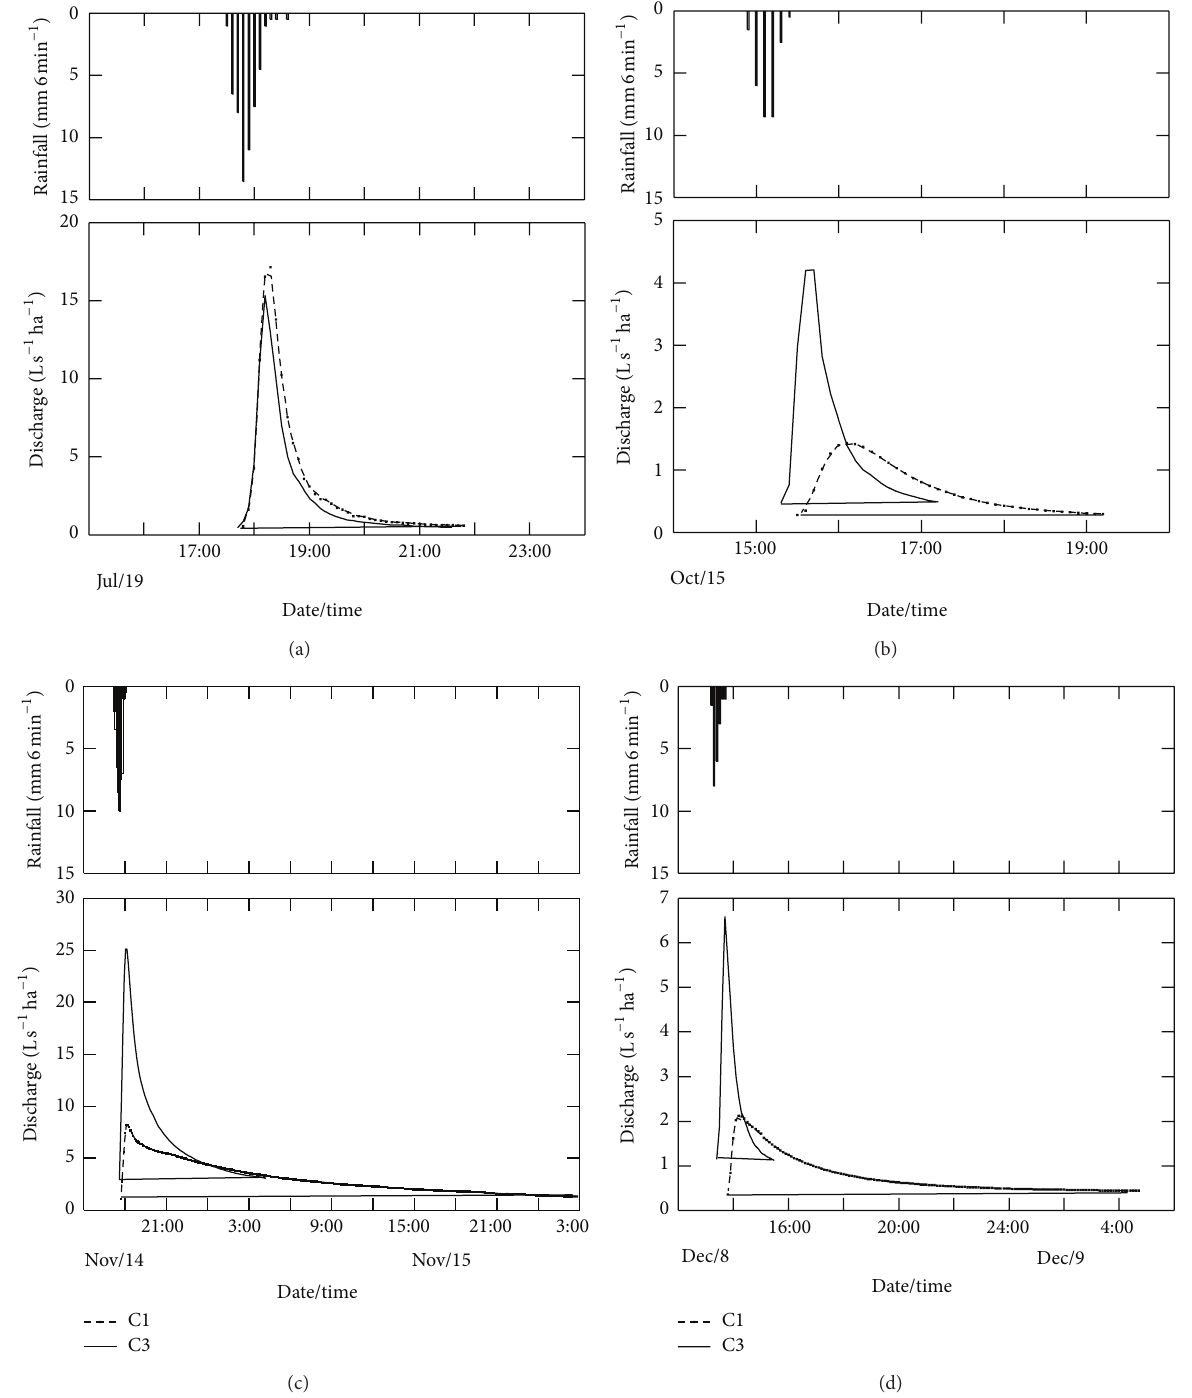
Figure 4: Stormflow hydrographs for C1 and C3 during (a) dry condition on 19 July 2006, (b) dry condition on 15 October 2006, (c) wet condition on 14 November 2006, and (d) wet condition on 8 December